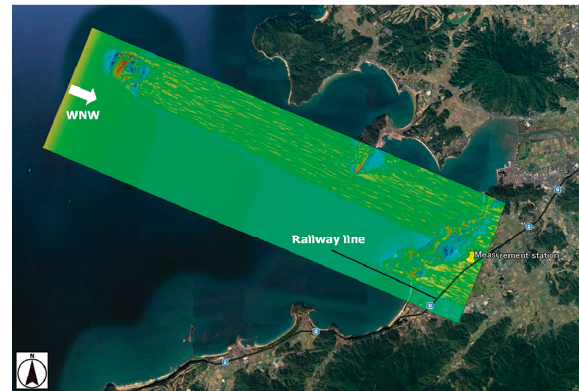
Figure 7: Wind speed distribution in the mainstream direction x , instantaneous flow field, and horizontal cross-section 5m above